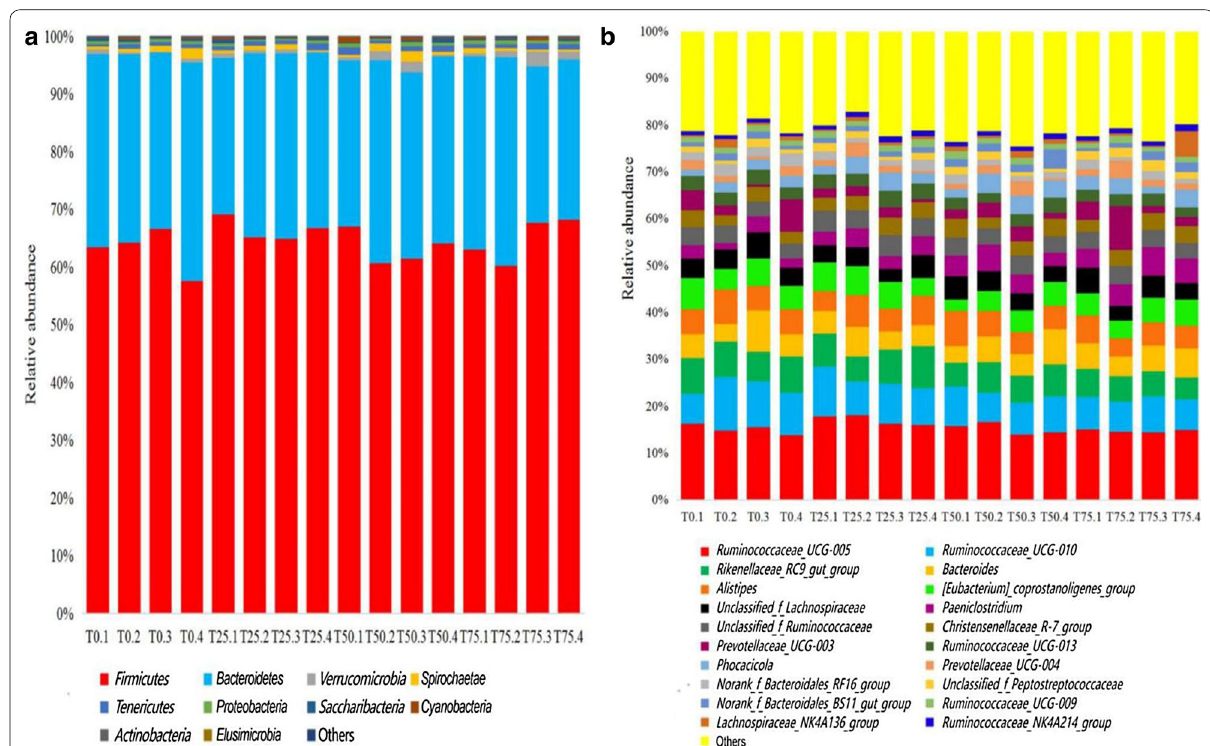
Fig. 6 Relative abundance of fecal bacterial community on the phylum and genus level. Figure 6a is the relative abundance on the phylum level; Fig. 6b is the relative abundance on the genus level. T0: BPS replaces 0% of WCS; T25: BPS replaces 25% of WCS; T50: BPS replaces 50% of WCS; T75: BPS replaces 75% of WCS. Numbers 1, 2, 3 and 4 in names of samples refer to individual heifers per set of treatment. BPS, Broussonetia papyrifera silage; WCS, whole corn